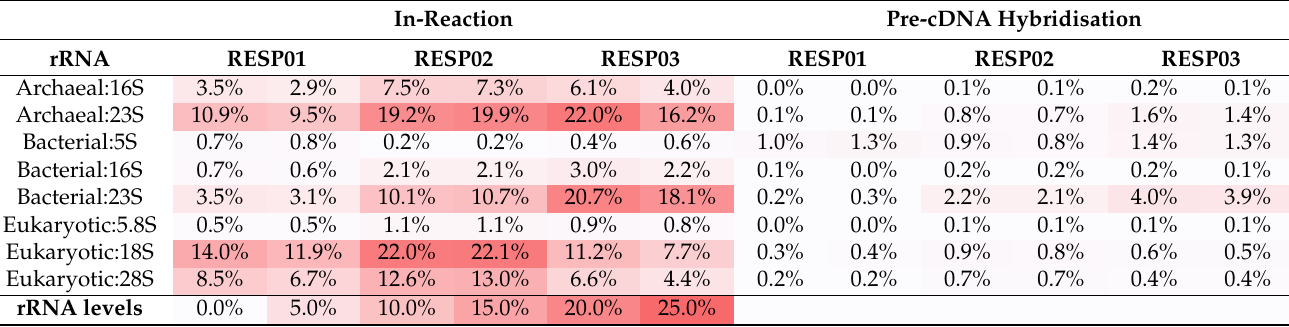
Table 2. Relative abundance of archaeal, bacterial, and eukaryotic rRNA using two different ap- proaches, with red shading indicating greater read depth as per the key provided at the bottom of the table.